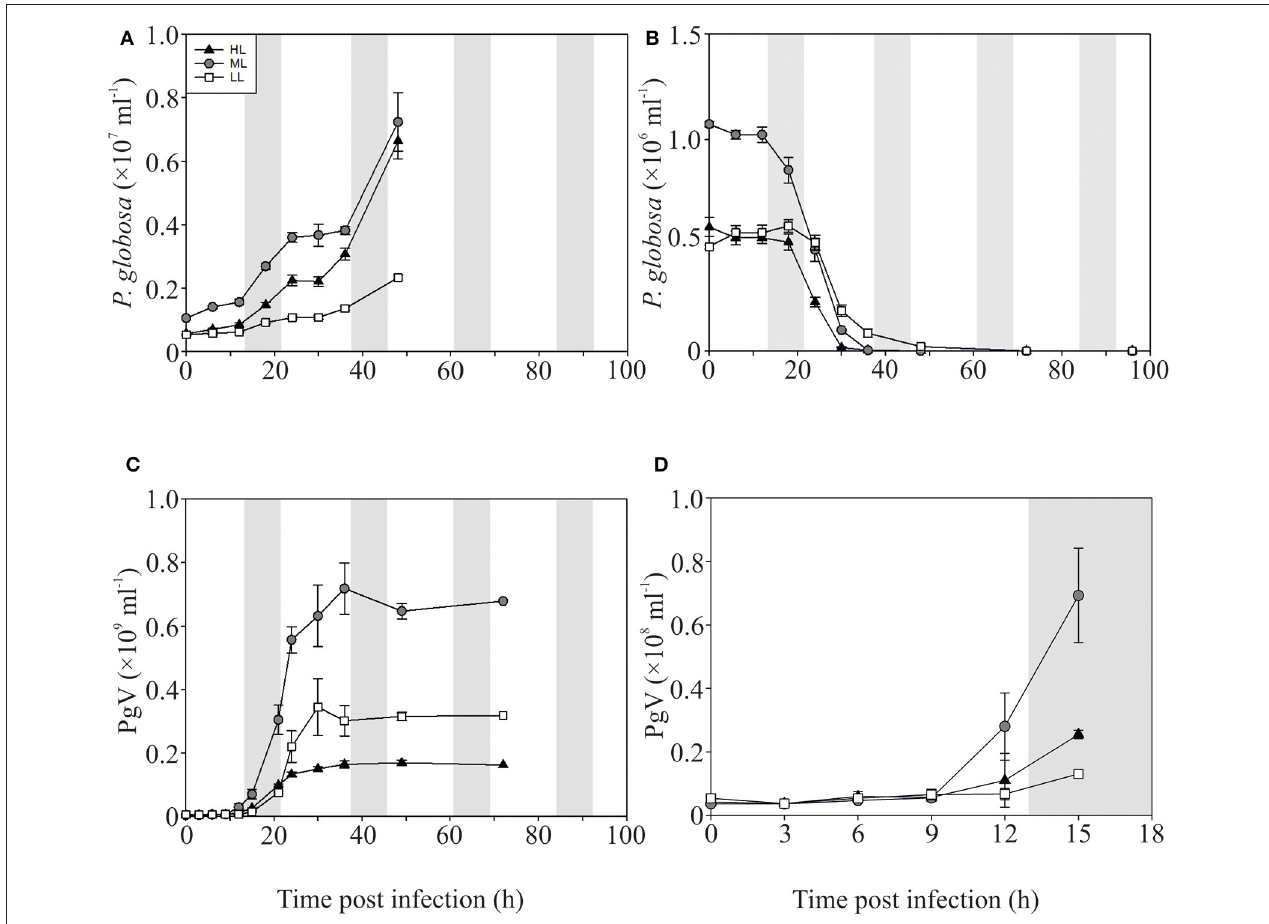
FIGURE 4 | Algal and viral growth curves with abundances of non-infected (A) and infected (B) Phaeocystis globosa and MpV (C) under P-replete conditions. (D) Shows PgV abundances in the first 15h in more detail. Light treatments are depicted by triangles (HL), circles (ML), and squares (LL). Values are averages ± s.d. Gray bar depicts dark (night)